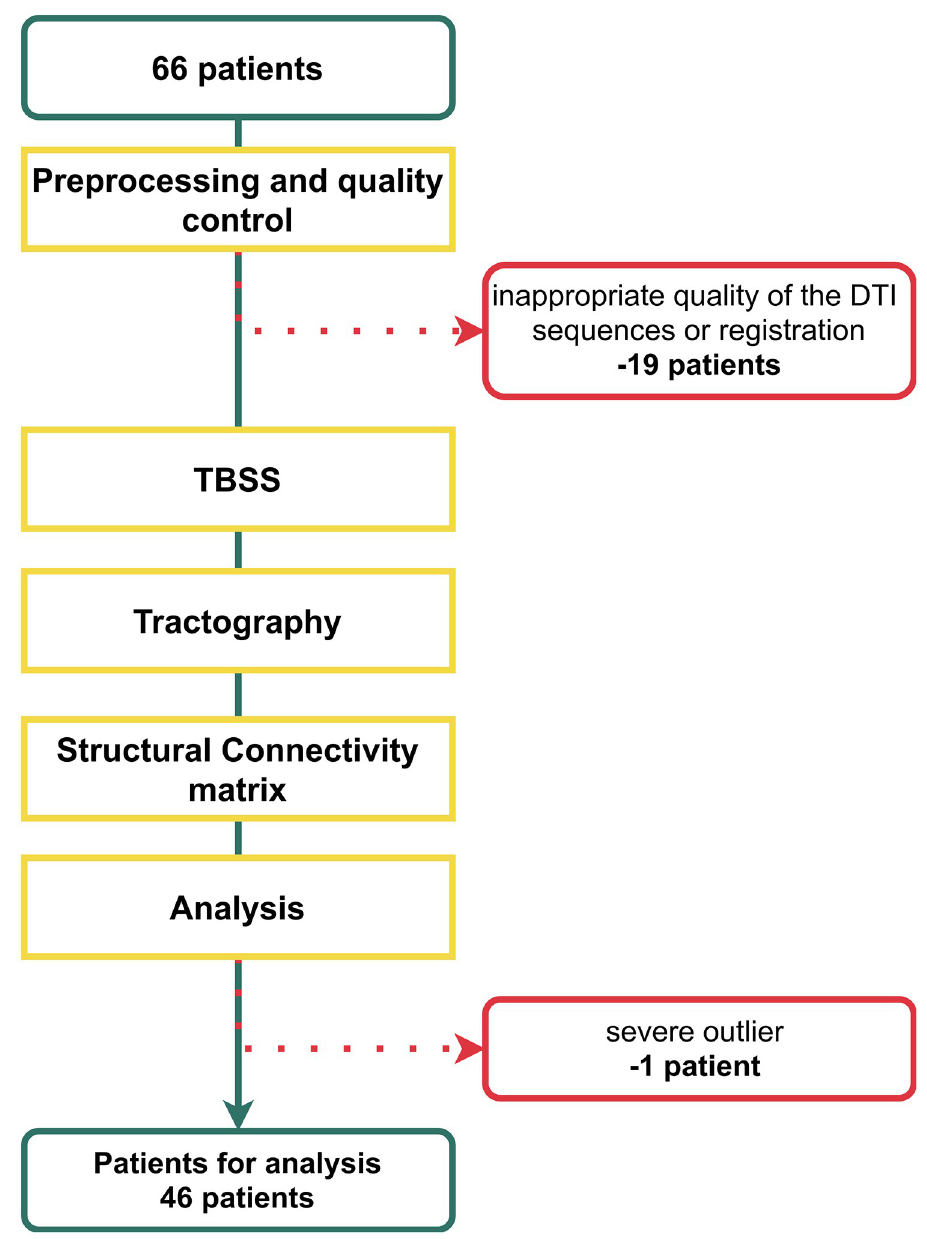
Fig 1. An overview of the analytical process. Initially the data of 66 patients were acquired. The data of 19 patients were discarded because of the unsuitable quality of the diffusion images or unsuccessful image registration. Moreover, we identified one severe outlier in neuropsychological performance who was not included in the analysis. Overall, the data of 46 patients were analysed.